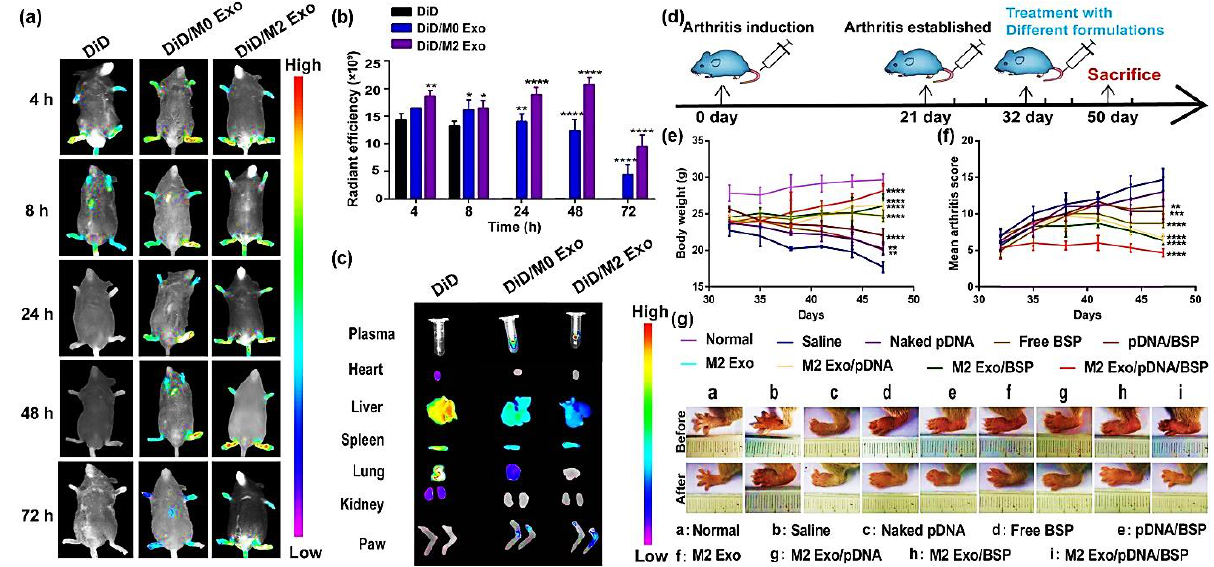
Figure 6. DiD-labelled formulation in vivo biodistribution. ( a ) Mice imaging with CIA at various time points after IV injection with DiD/M2 Exo, DiD/M0 Exo, free DiD (n = 3). ( b ) Ankle joint analysis of fluorescence intensity. * p < 0.05, ** p < 0.001, **** p < 0.0001. ( c ) DiD labelled and free DiD formulations’ biodistribution in blood as well as different organs after 72 h of injection. ( d ) Quantitative evaluation of M2 Exo/pDNA/BSP therapeutic efficacy in CIA mice showing the establishment of RA and treatment procedure. Measurement of ( e ) body weight and ( f ) average articular score. *** p < 0.001, **** p < 0.0001.( g ) Images of mice hind legs both before and after treatment with numerous formulations of drugs. Adapted from [92] with